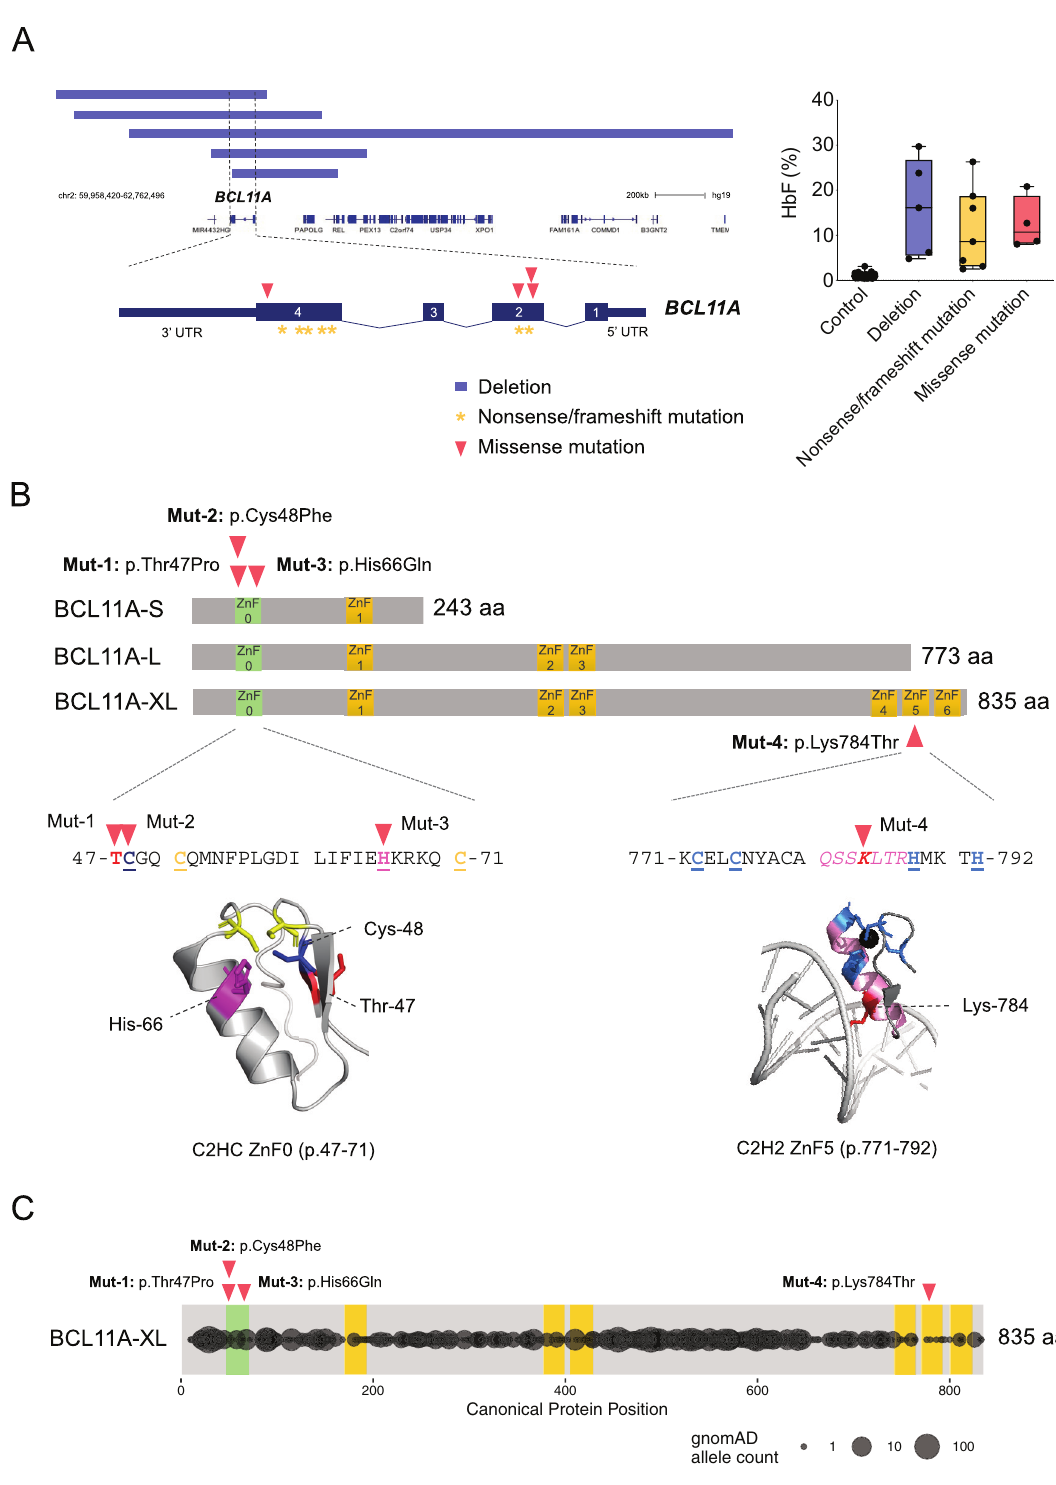
Fig 1. Characterization of pathogenic missense variants in BCL11A. (A) Left panel: Schematic of pathogenic de novo deletion, nonsense/frameshift, and missense mutations impacting BCL11A . Right panel: Fetal hemoglobin levels of the three categories of variants compared with control cohort. (B) Schematic representation of 4 reported BCL11A missense mutations and their locations in a C2HC zinc-finger (ZnF0) at the N-terminal region of BCL11A isoforms (BCL11A-S, BCL11A-L, BCL11A-XL) and the fifth zinc finger domain (ZnF5) at the C-terminal region of BCL11A-XL. (C) Distribution of BCL11A genetic variants from the gnomAD database.